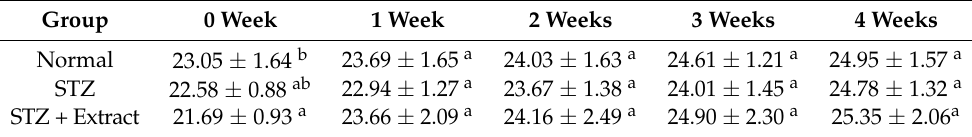
Table 4. The changes of body weight (g) in mice for feeding RF-dried bitter gourd extract. Group 0 Week 1 Week 2 Weeks 3 Weeks 4 Weeks Normal 23.05 ± 1.64 b 23.69 ± 1.65 a 24.03 ± 1.63 a 24.61 ± 1.21 a 24.95 ± 1.57 a STZ 22.58 ± 0.88 ab 22.94 ± 1.27 a 23.67 ± 1.38 a 24.01 ± 1.45 a 24.78 ± 1.32 a STZ + Extract 21.69 ± 0.93 a 23.66 ± 2.09 a 24.16 ± 2.49 a 24.90 ± 2.30 a 25.35 ± 2.06 a